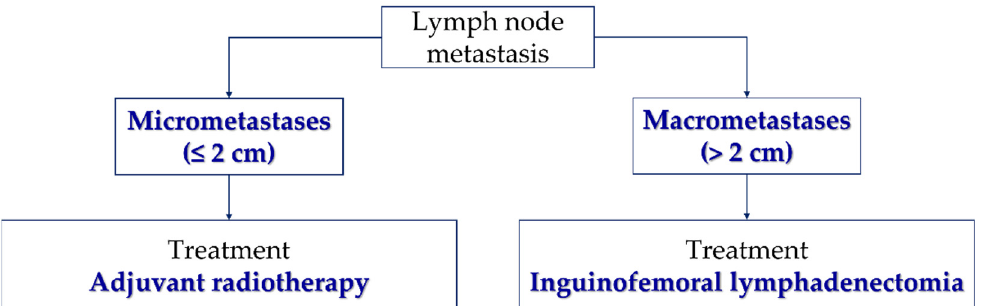
Figure 5. Flowchart of the treatment of metastatic lymph nodes.